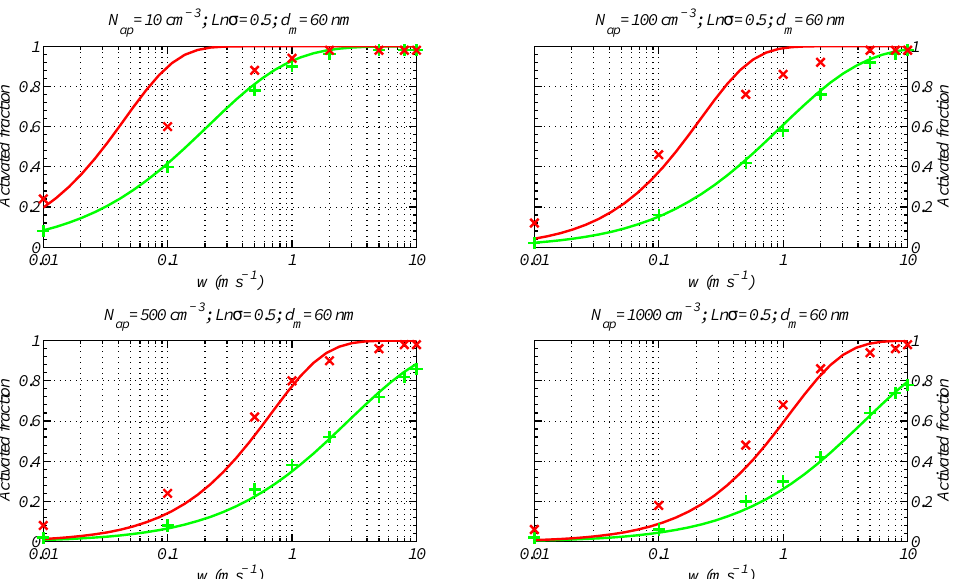
Fig. 7. Same as for the dashed lines in Figure 6 but with the ‘core’ aerosol size distribution composition set to 90% semi-volatile : total (by mass).